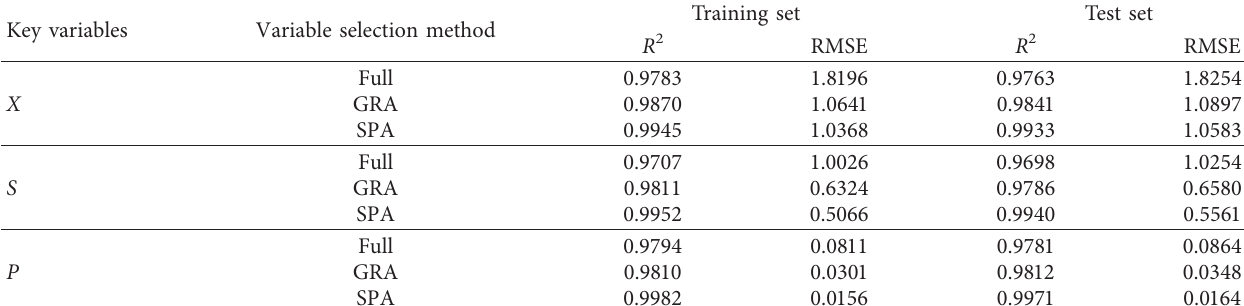
Table 4: Quality prediction results based on SPA-GWO-SVR soft sensor model.